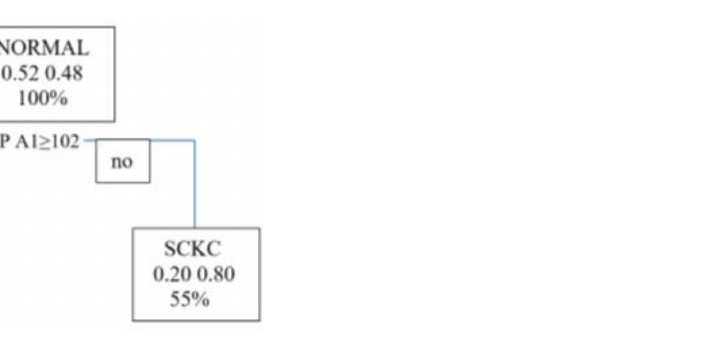
Figure 1. Decision tree. SPA1= Stiffness Parameter at first Applanation; SCKC=Subclinical Kerato- conus.